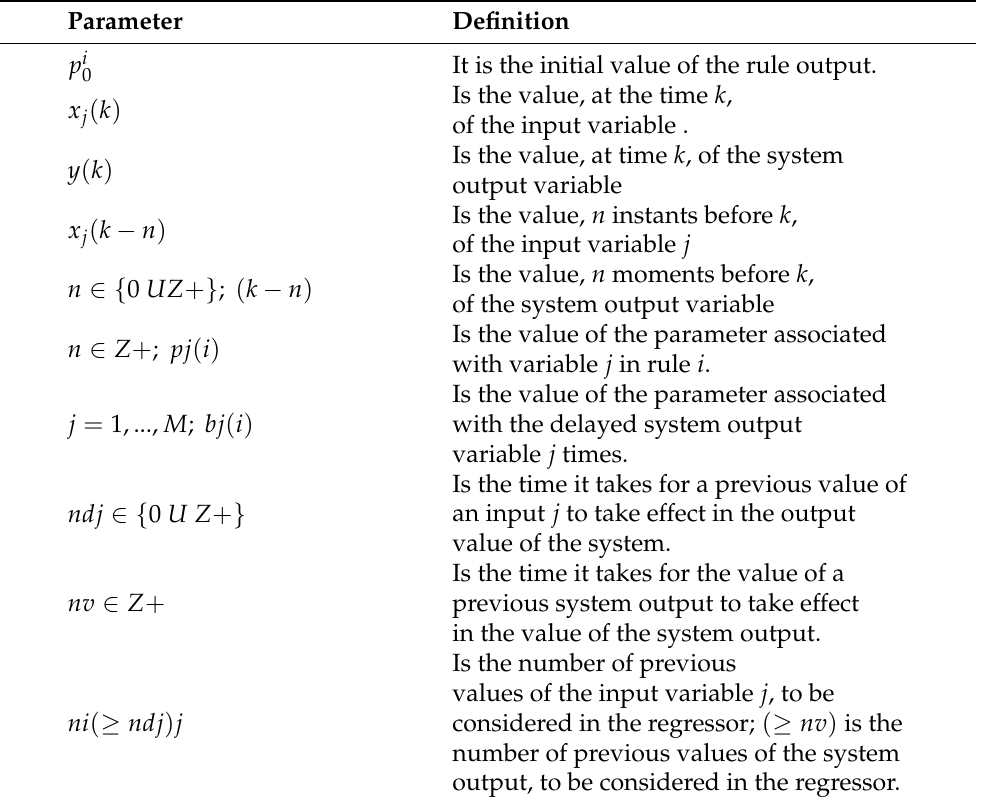
Table 1. Description of the variables of Equations (1) and (2) NMPC.